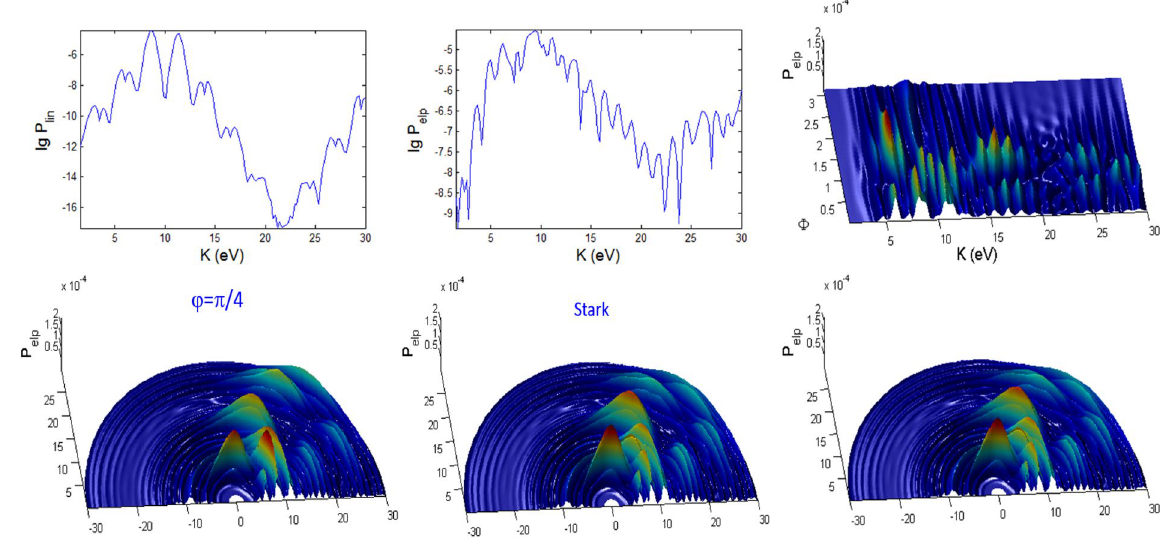
Figure 9. Photoionization probability with t p = 10 fs versus angle Φ at Θ = π /2 and kinetic energy K for the case A (intermediate regime). There is no Stark effects and the CEP phase ϕ = 0, unless stated otherwise. Only the panels labelled with Stark have finite coefficient